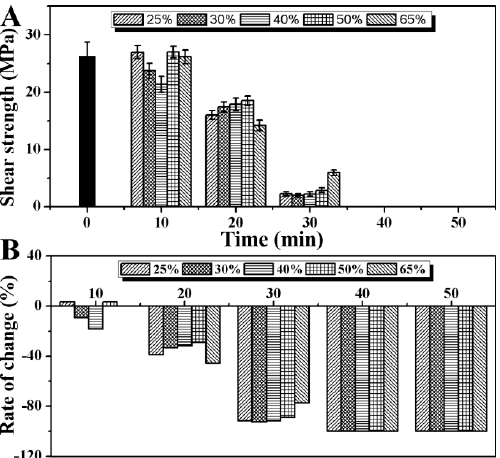
Figure 4. The changes in shear strength ( A ) and corresponding change rate ( B ) with heat treatment time.